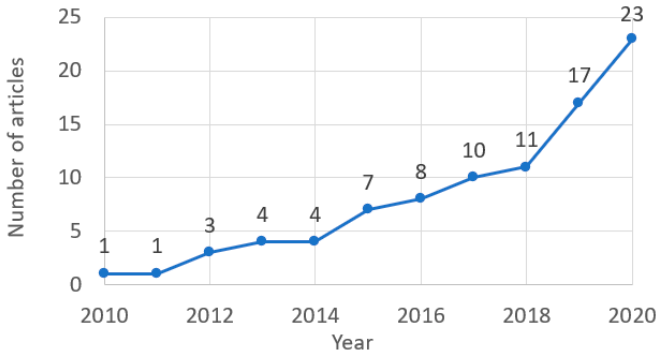
Figure 4. Number of articles distributed in different years.